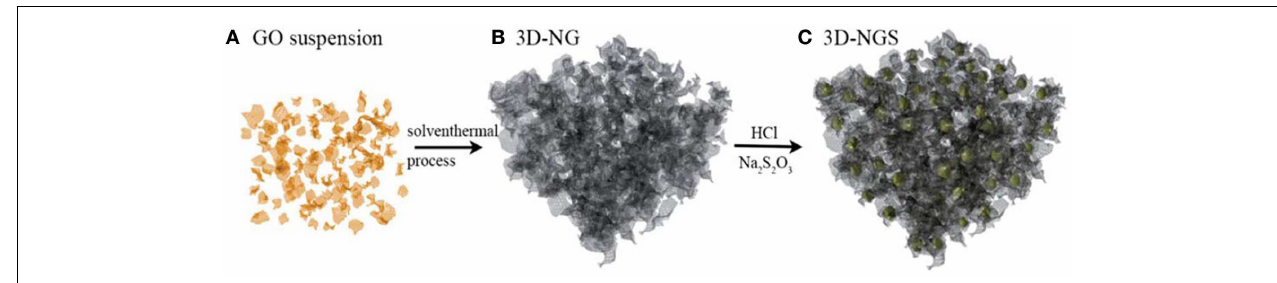
FIGURE 6 | Synthetic step of 3D-nitrogen doped graphene–sulfur composite (3D-NGS) (Wang et al., 2014a) .